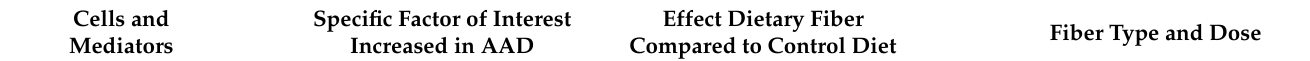
Table 1. Overview of immune effects of fermentable fibers in preclinical asthma